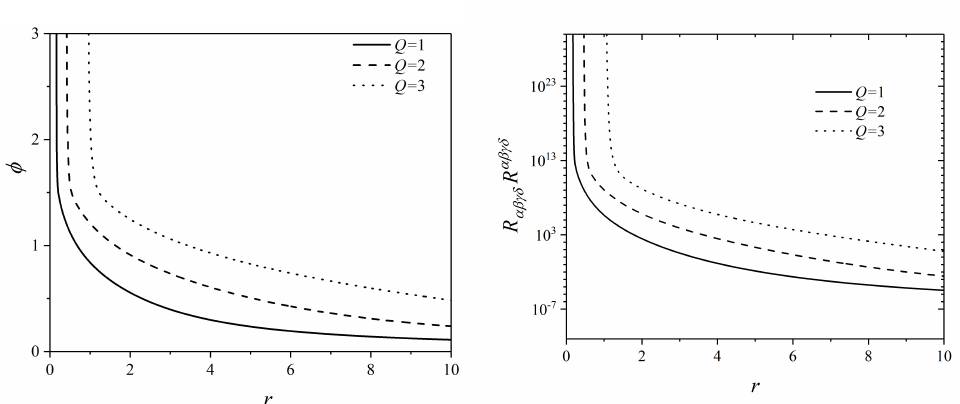
Figure 2. Behavior of SF ( left ) and Kretschmann invariant R αβγδ R αβγδ ( right ) for the same parameters.